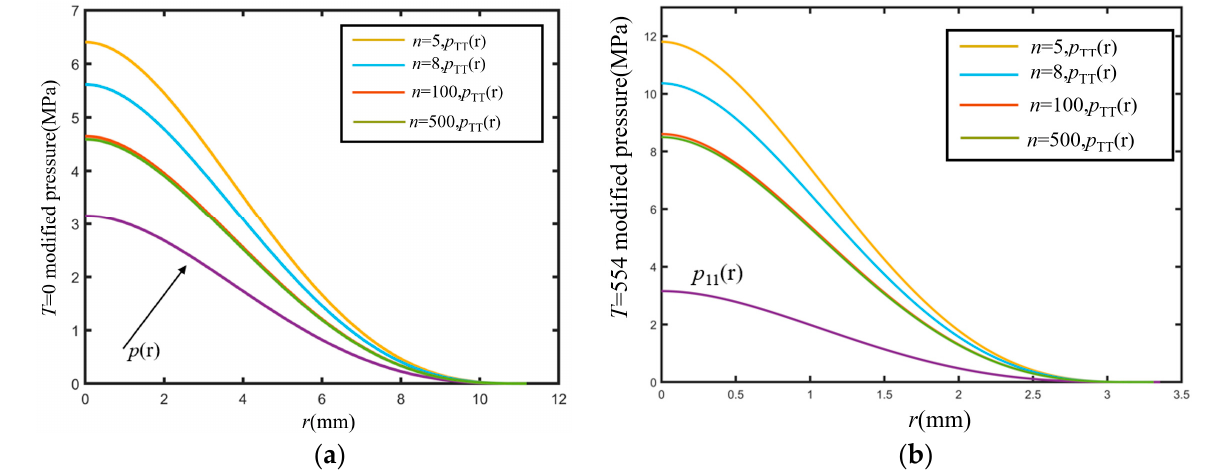
Figure 13. High-order discrete pressure correction: ( a ) T = 0 N; ( b ) T = 554